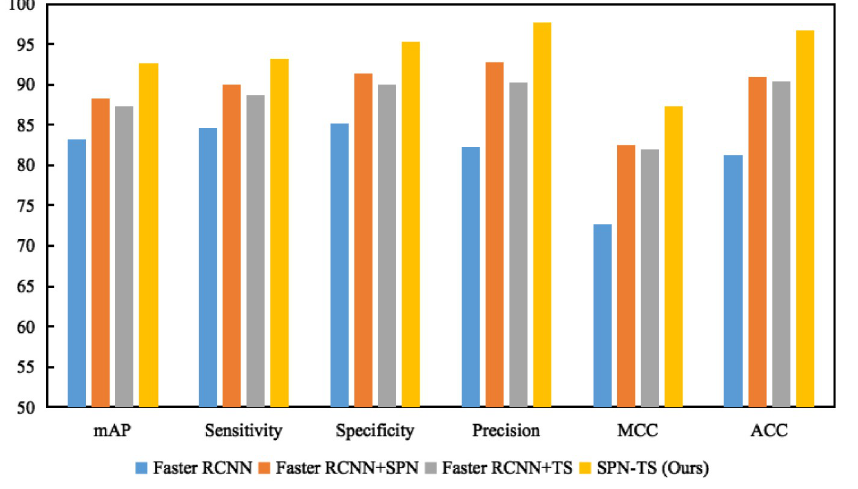
Fig 8. The histogram results of the ablation experiment